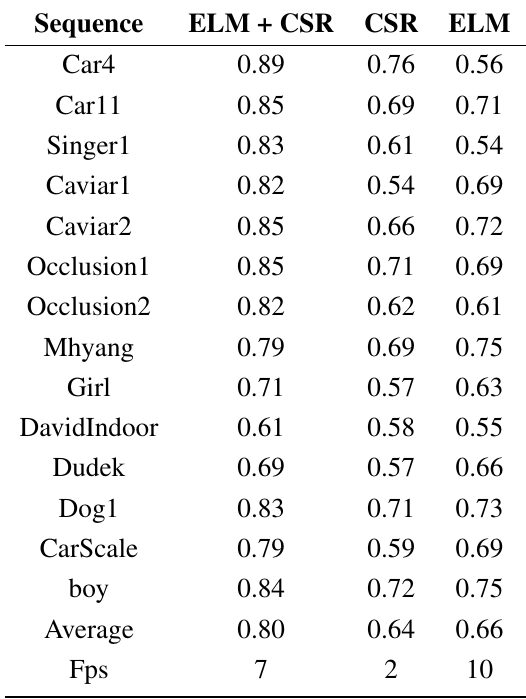
Table 6. Self-comparisons in terms of VOR ( % ) and frames per second